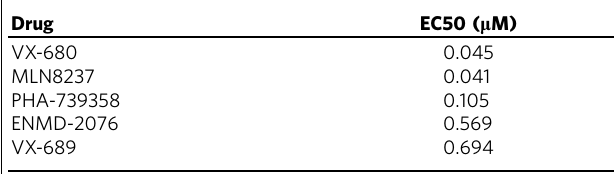
Table 1 | Response of NCI-H1819 to AURKA inhibitors.